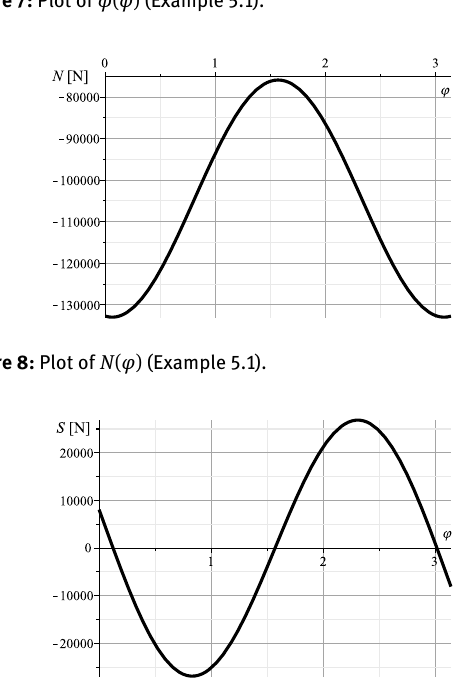
Figure 7: Plot of ϕ ( φ ) (Example 5.1).